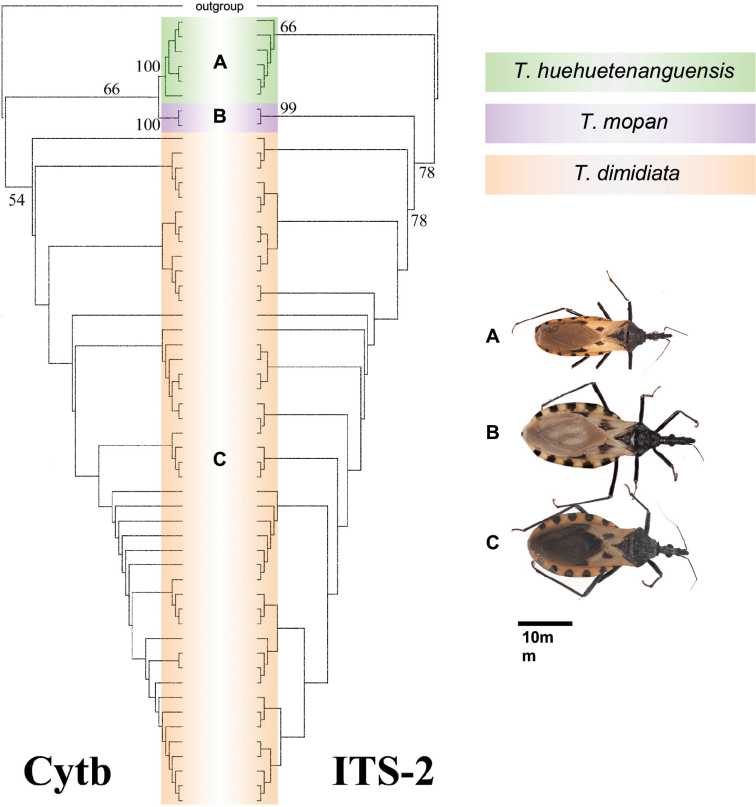
Maximum likelihood cytB and ITS-2 phylogenies. Bootstrap support values of the relevant clades are shown. Habitus of T.huehuetenanguensis and related species are shown to scale (10 mm).